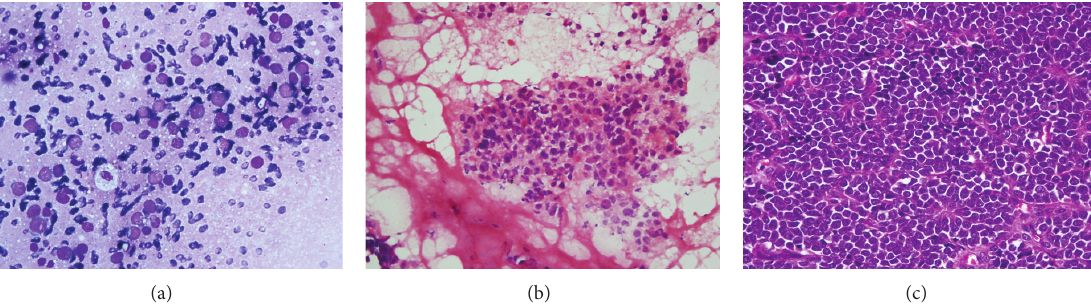
Figure 4: (a–c) Ewing’s sarcoma: (a) imprint smear shows scattered population of malignant round tumor cells with larger cells having pale stained nuclei and smaller cells having darkly stained nuclei; cytoplasm is vacuolated (MGG stain, × 400); (b) frozen section shows sheet of small round tumor cells with occasional rosette formation (H&E, × 400); (c) malignant small round tumor cells arranged in sheets and pseudorosettes are identified in paraffin embedded section. Note mitotic figures (H&E, ×